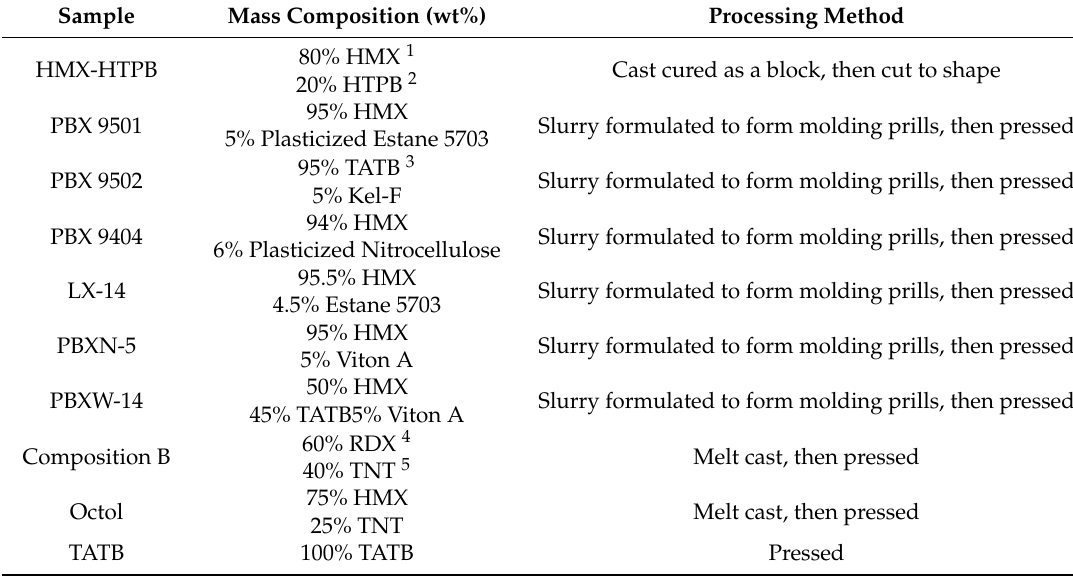
Table 1. High explosive materials studied with µ